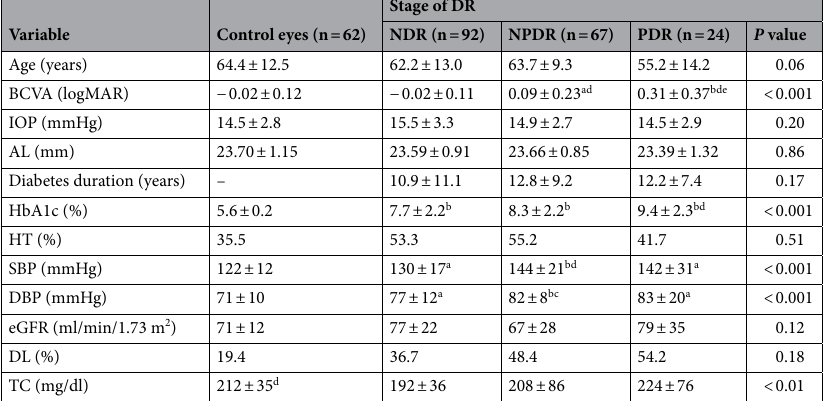
Table 1. Clinical characteristics in subjects examined in this study. DR, diabetic retinopathy; NDR, no DR; NPDR, no proliferative DR; PDR, proliferative DR; BCVA, best corrected visual acuity; logMAR, logarithm of the minimum angle of resolution; IOP, intraocular pressure; AL, axial length; HbA1c, hemoglobin A1c; HT, hypertension; SBP, systolic blood pressure; DBP; eGFR, estimated glomerular filtration rate; diastolic blood pressure; TC, total cholesterol. a P < 0.05 versus control. b P < 0.01 versus control. c P < 0.05 versus NDR. d P < 0.01 versus NDR. e P < 0.05 versus